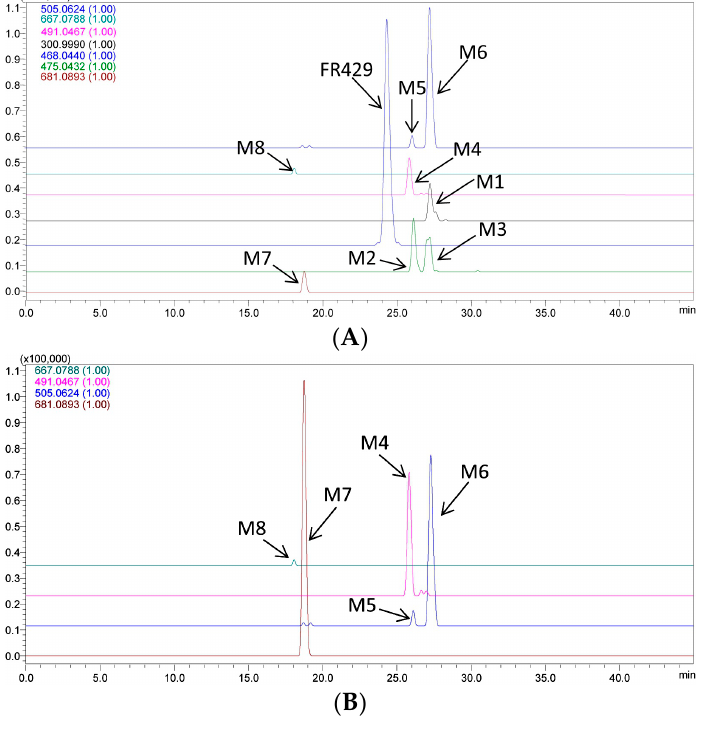
Figure 1. Representative extracted ion chromatograms (EICs) of the metabolites of FR429 in rats in vivo: ( A ) bile sample collected from 1 to 1.5 h; and ( B ) urine sample collected from 0 to 6 h.